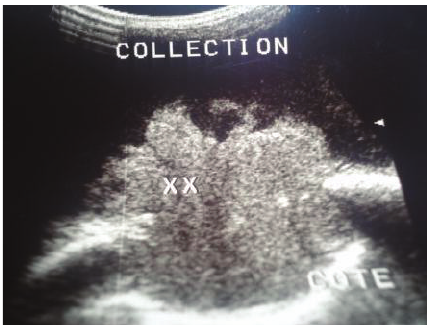
Figure 6: Computed tomography 3D reformation showing destruc- tion of the 7th